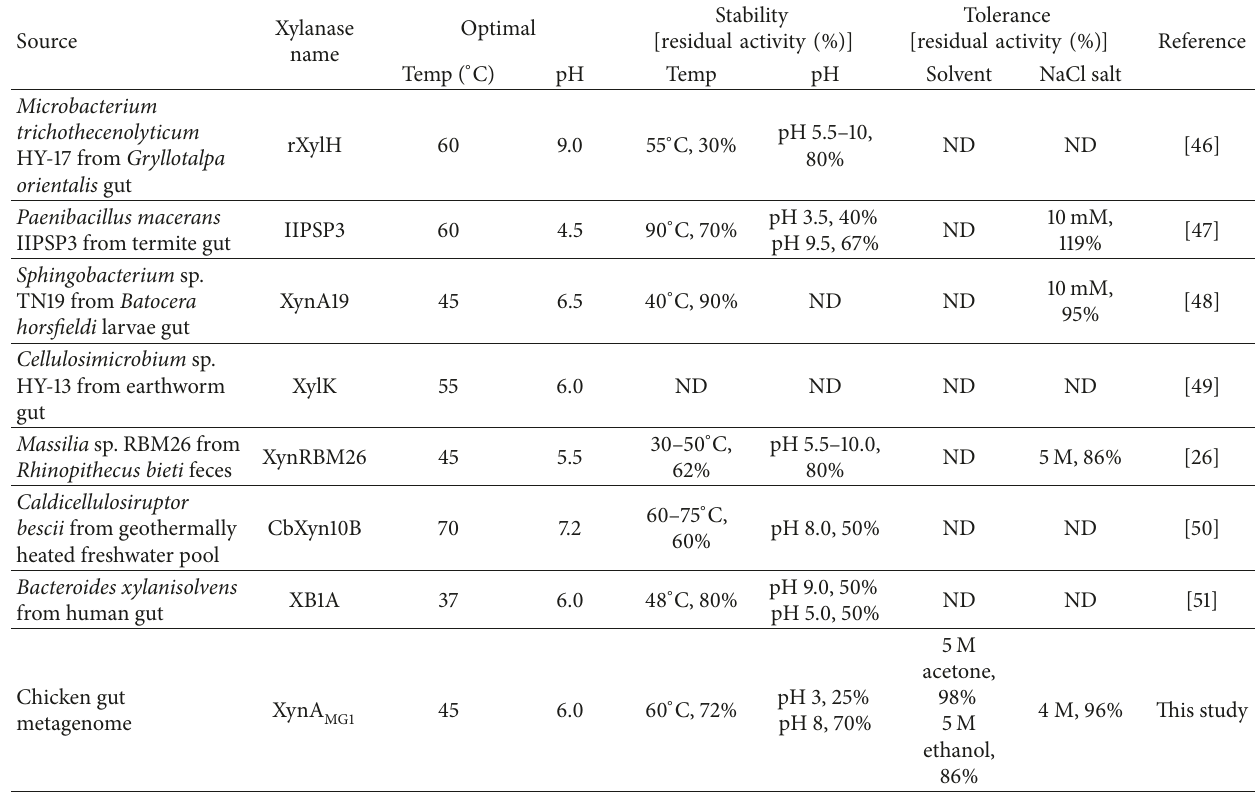
Table 3: Biochemical properties of GH10 xylanases from animal intestinal bacteria compared with XynA MG 1 .